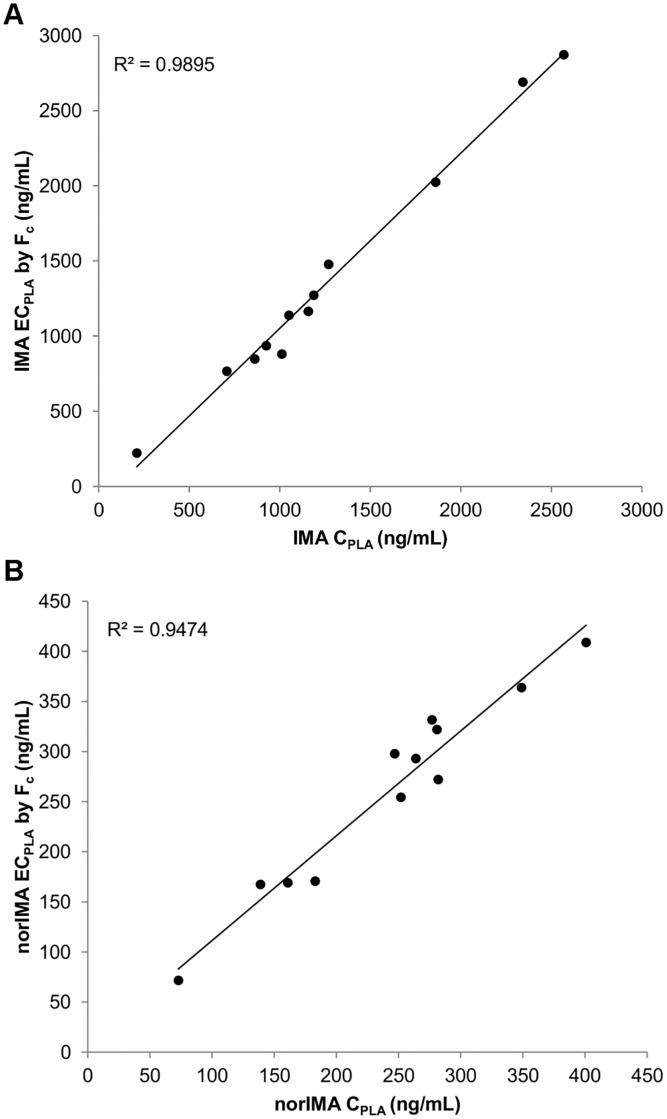
Fc application to 12 external DBS samples.Correlation graph between (A) IMA and (B) norIMA estimated plasma concentrations (ECPLA) by Fc and their corresponding plasma measurements (CPLA); N = 12.